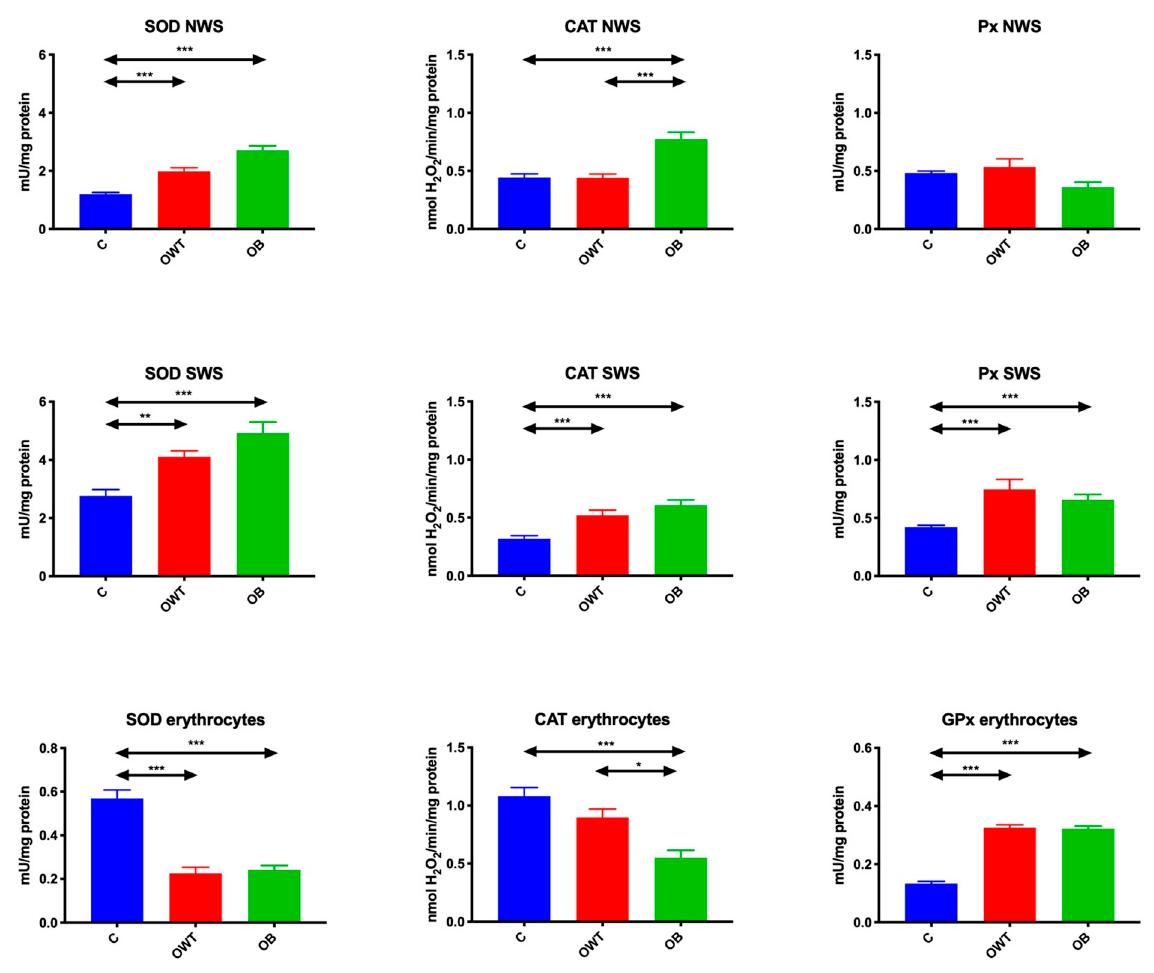
Figure 2. Enzymatic antioxidants in overweight and obese adolescents as well as healthy controls. C- control, CAT- catalase, NWS- non-stimulated whole saliva, OB- obese, OWT- overweight, Px- salivary peroxidase, SOD- superoxide dismutase, SWS- stimulated whole saliva. Differences statistically significant at: * p < 0,05, ** p < 0,005, *** p < 0,0005.